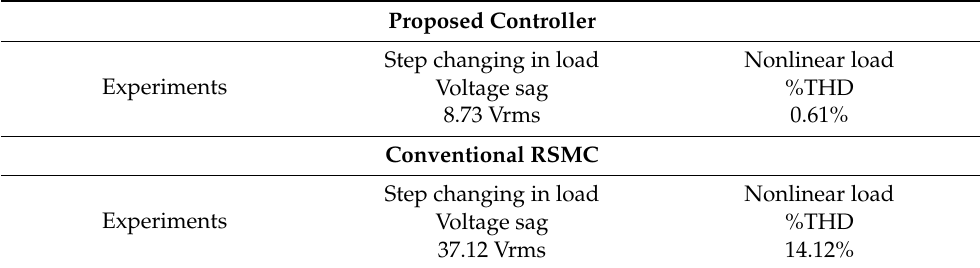
Table 2. Voltage sag and %THD of output